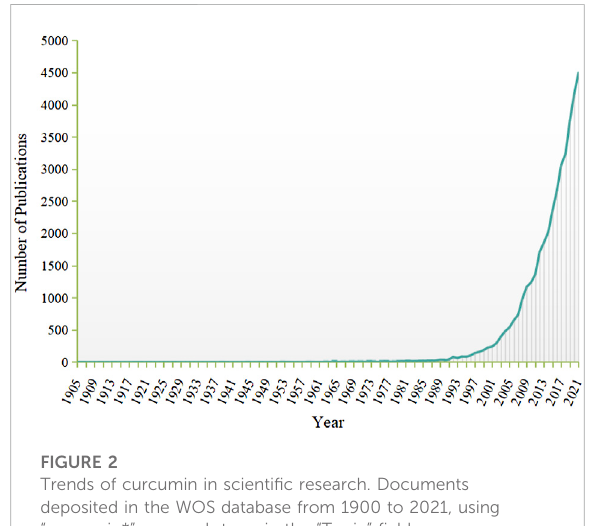
FIGURE 2 Trends of curcumin in scienti fi c research.